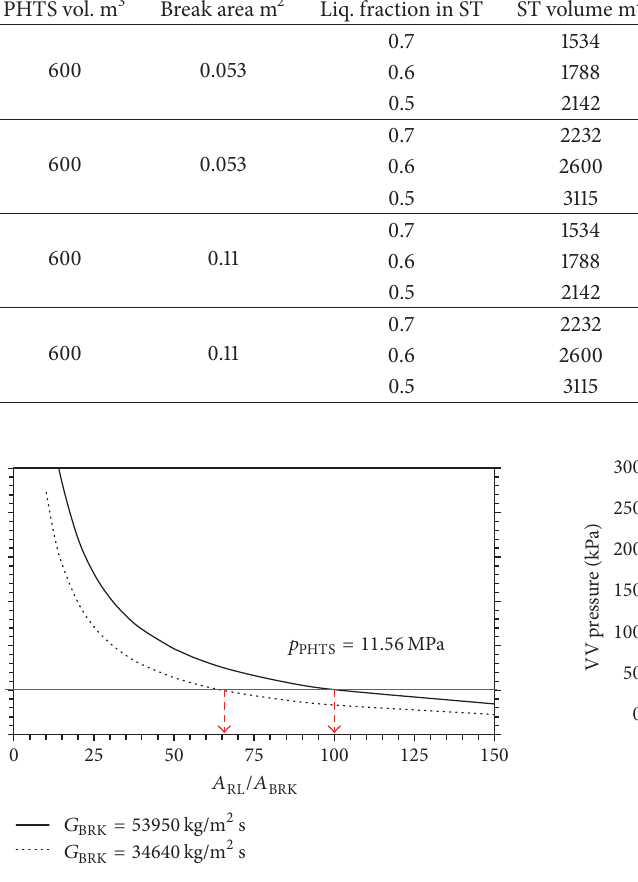
Figure 9: Peak pressure in the VV for a WCLL in-vessel LOCA.